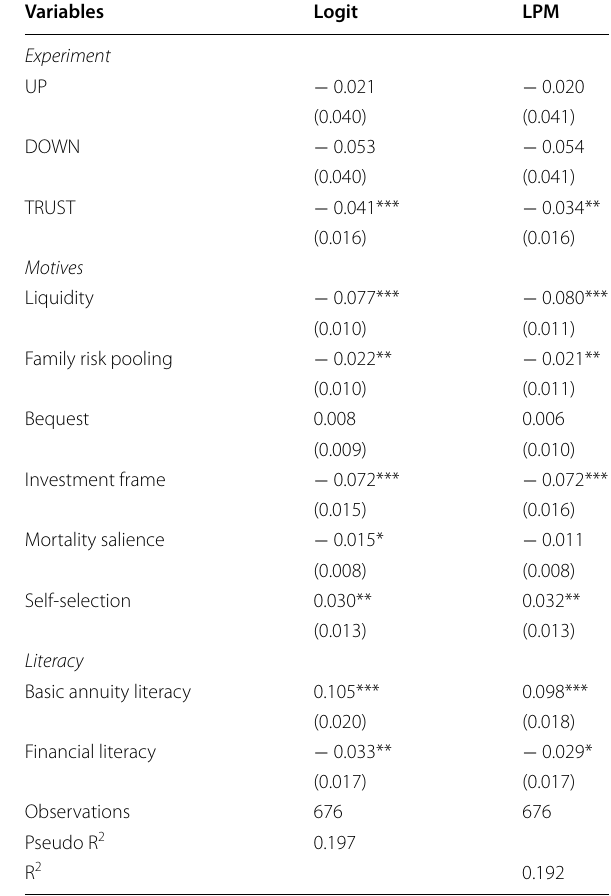
Table 8 Comparison of average marginal effects between logit model and